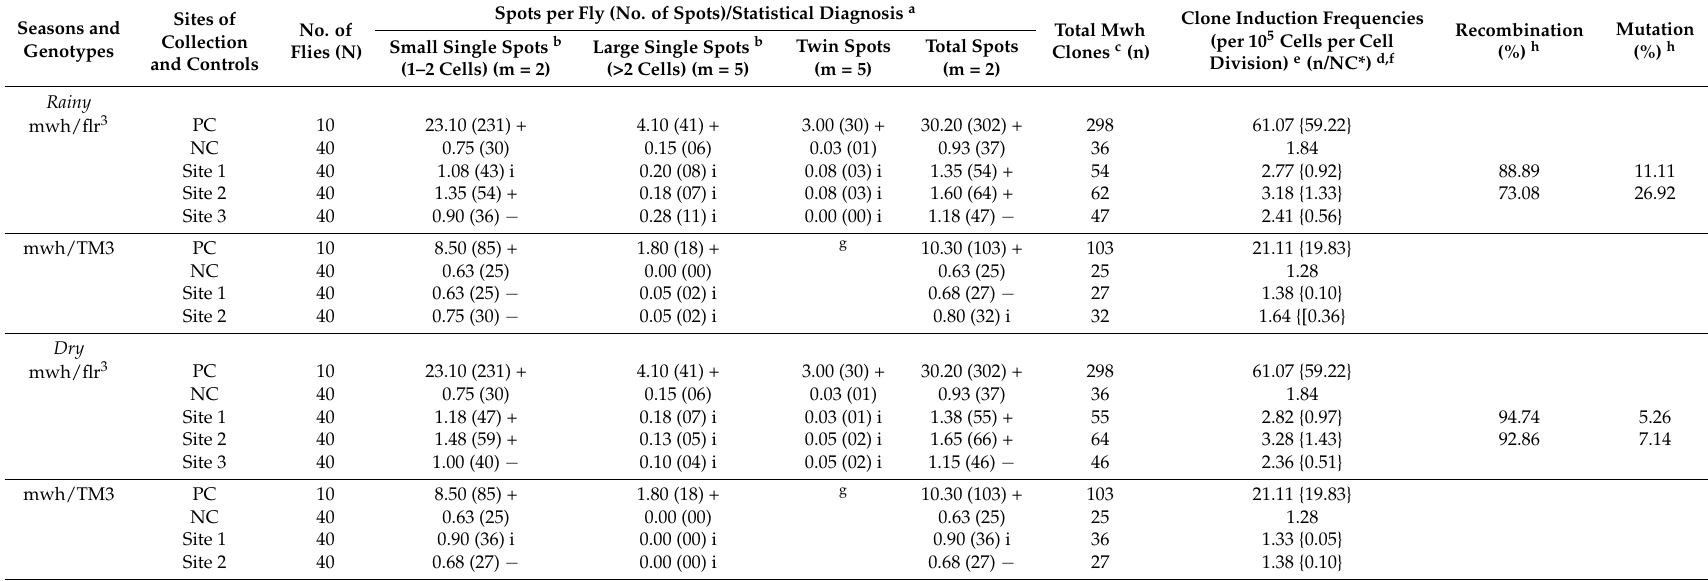
Table 4. Fly spot data obtained after exposure of marker and balancer heterozygous larvae of D. melanogaster to surface water of Tocantins River in HB cross. Sites of Seasons and Genotypes